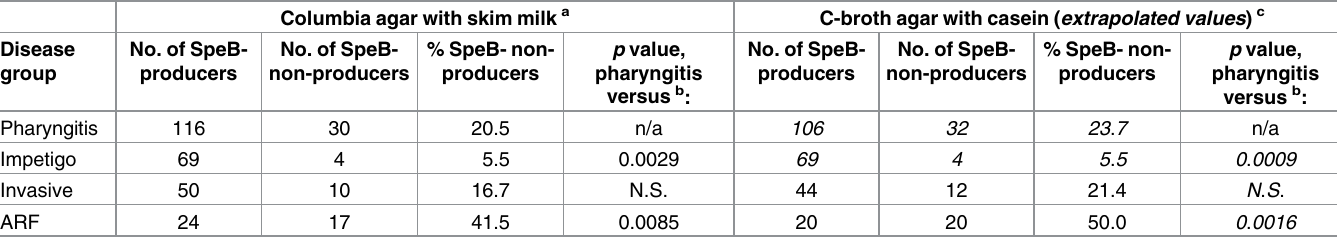
Table 2. SpeB activity phenotype correlateswith GAS